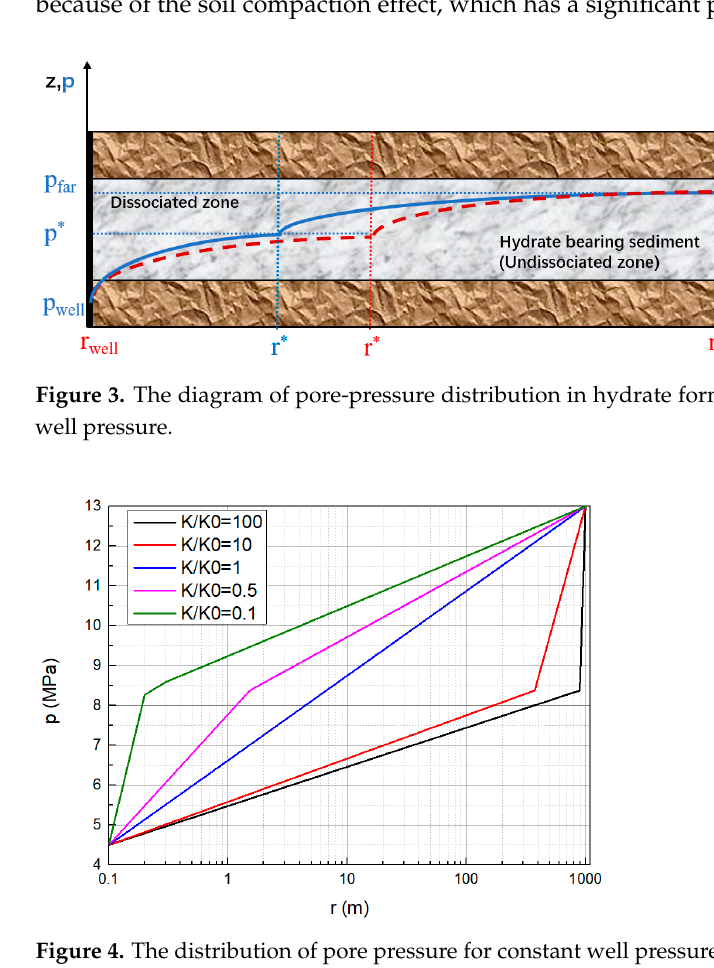
Figure 4. The distribution of pore pressure for constant well pressure.